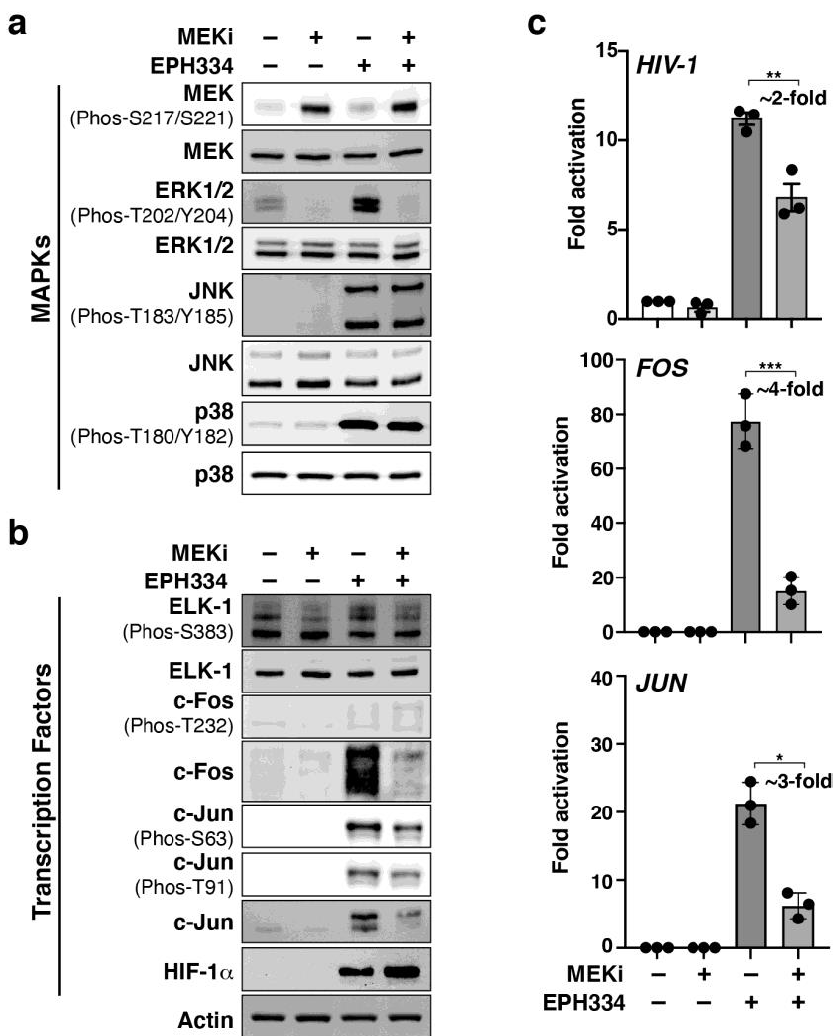
Figure 7. Pharmacologic inhibition of MEK signaling blocks EPH334-mediated AP-1 induction, thereby dampening latent HIV-1 reactivation. ( a , b ) Western blots of J-Lat 10.6 cells pretreated for 1 h with MEKi (PD0325901, 1 µ M) or vehicle control (DMSO) and then treated for 8 h with EPH334 (2.5 µ M) or vehicle control (DMSO) and probed with the indicated antibodies. ( c ) RT-qPCR assays of J-Lat 10.6 cells pretreated for 1 h with MEKi (PD0325901, 1 µ M) or vehicle control (DMSO) and then treated for 8 h with EPH334 (2.5 µ M) or vehicle control (DMSO). Quantitation of the indicated RNAs normalized to RPL19 by RT-qPCR (mean ± SEM; n = 3). p -values (* p < 0.05, ** p < 0.01, *** p < 0.001, ns = not significant) were determined by unpaired Student’s t test. p < 0.05 was considered statistically